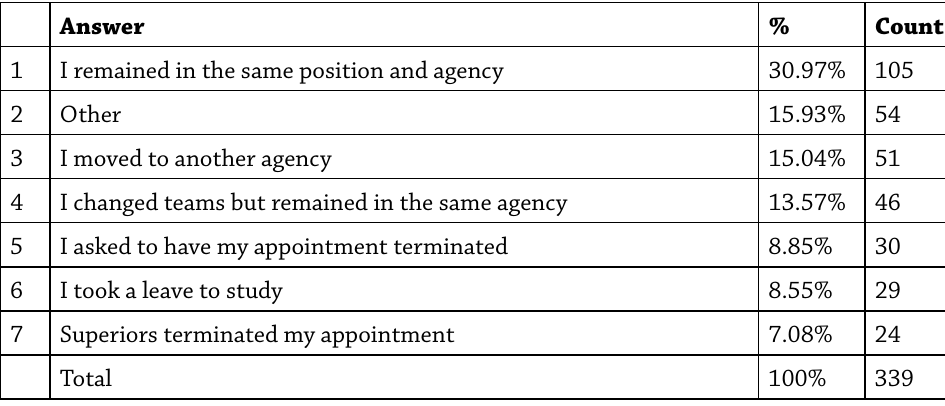
Table 4. Career decisions after the 2018 elections